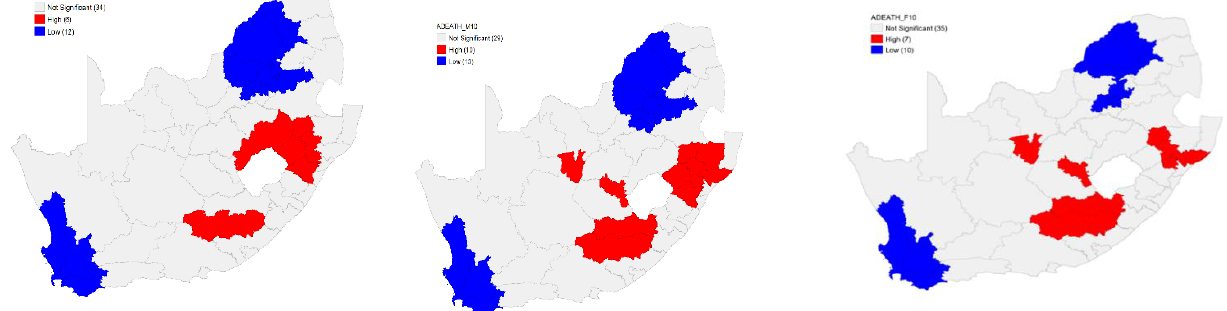
Figure 4. Local G hot and cold spots for the overall ( left ), male ( middle ), and female ( right ) age-sex-standardised TB death rates by district municipality,